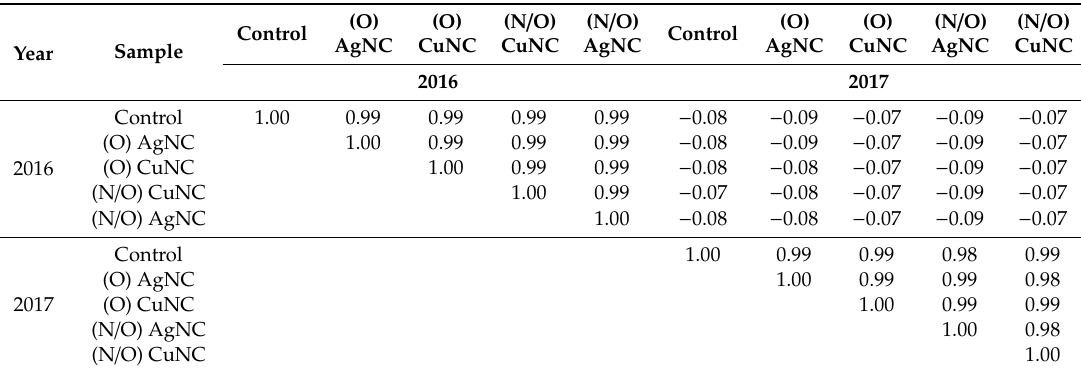
Table 5. The similarity of FTIR spectra of 10 oil samples.